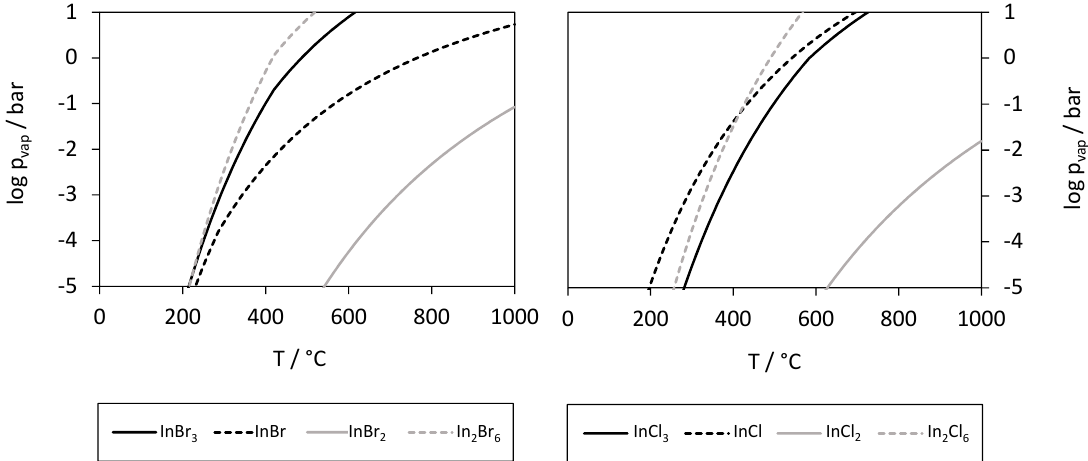
Figure 7. Vapor pressure curves of pure indium bromides ( left ) and indium chlorides ( right ).